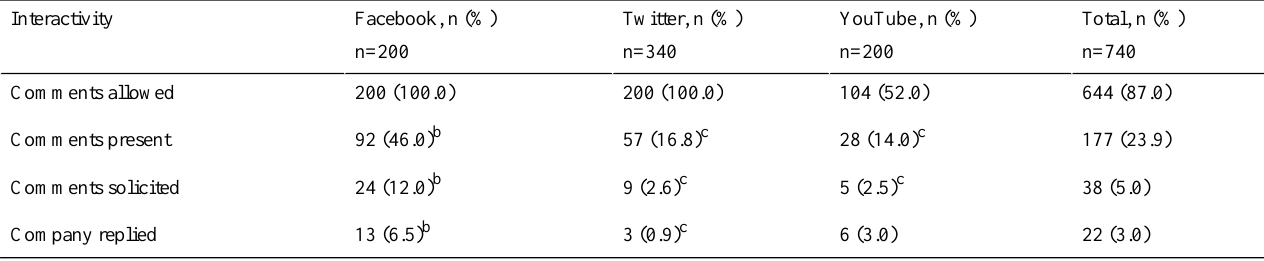
Table 4. Interactivity on company-run social media pages.